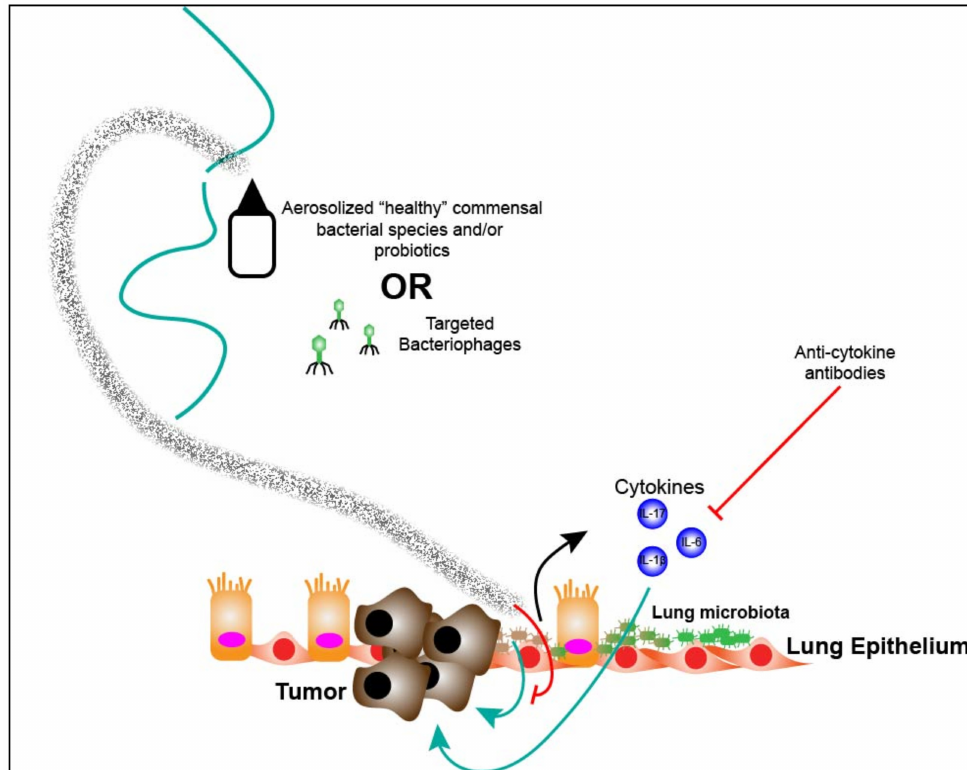
Figure 3. Targeting the lung microbiome. Aerosolization of “healthy” commensal respiratory bacteria, probiotics or bacteriophages targeted against dysbiotic bacteria in the lung could disrupt pathogenic lung dysbiosis in lung cancer patients and lead to anti-tumorigenic effects. Immunologic downstream effects of lung dysbiosis in lung cancer patients could lead to the use of specific anti- cytokine antibodies to modulate the inflammatory milieu promoting a more anti-tumorigenic tumor microenvironment within the